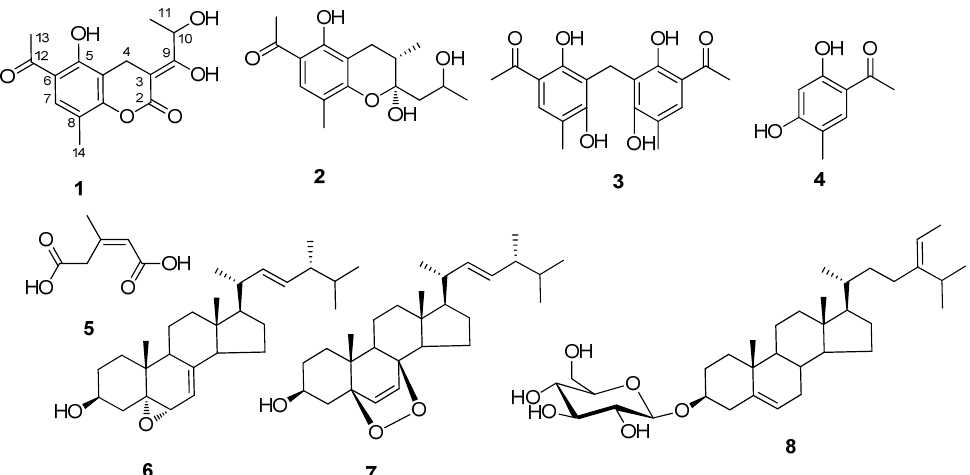
Figure 1. Structures of compounds 1 - 8